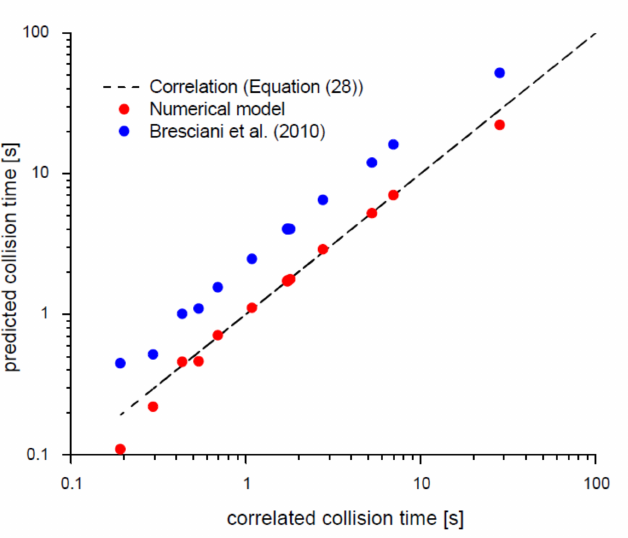
Figure 4. Predicted collision time by the correlation Equation (11) versus collision time in logarithmic